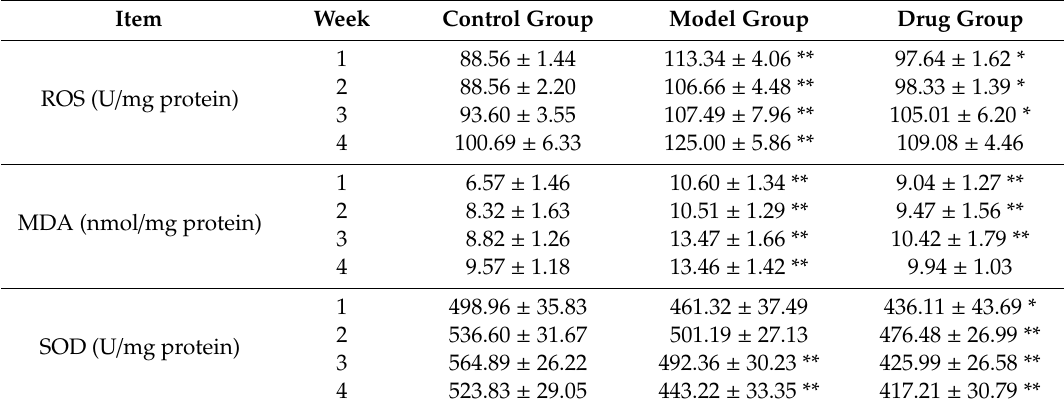
Table 4. The level of hepatic ROS, MDA, and SOD.